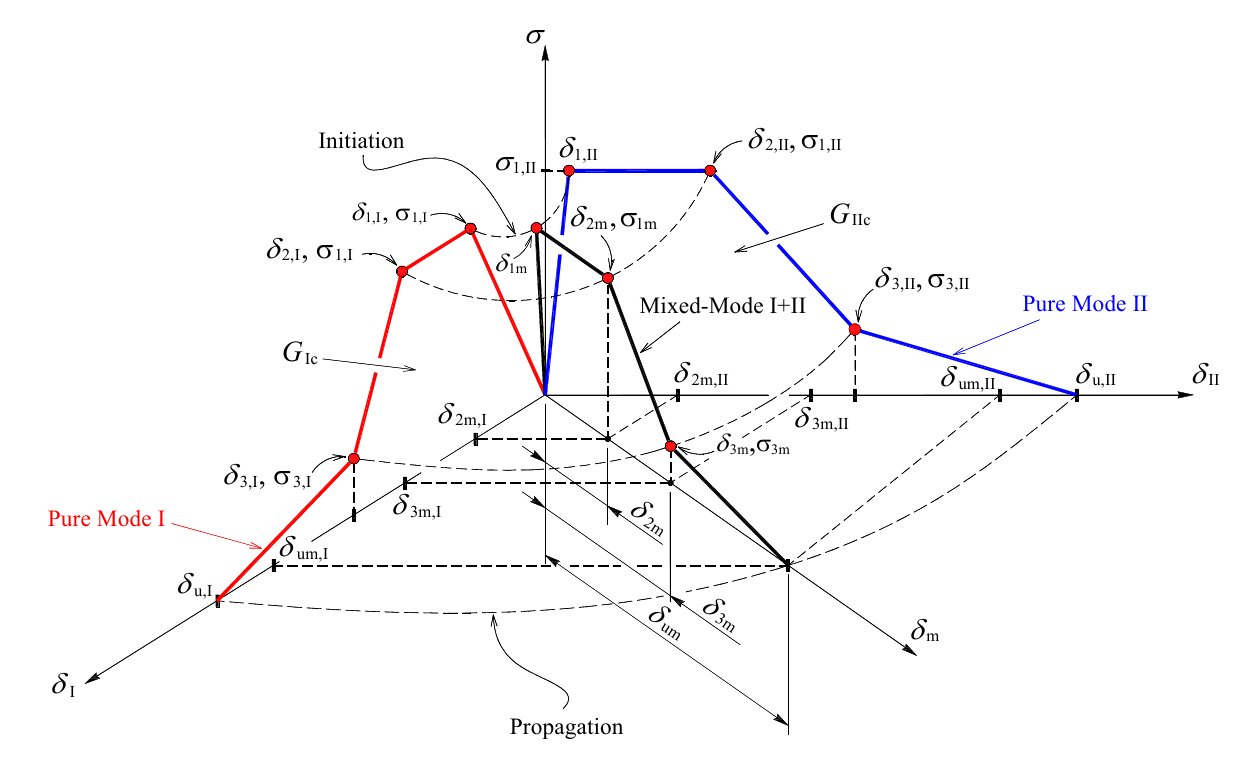
Figure 9. Mixed ‐ mode I+II cohesive law. Figure 9. Mixed-mode I+II cohesive